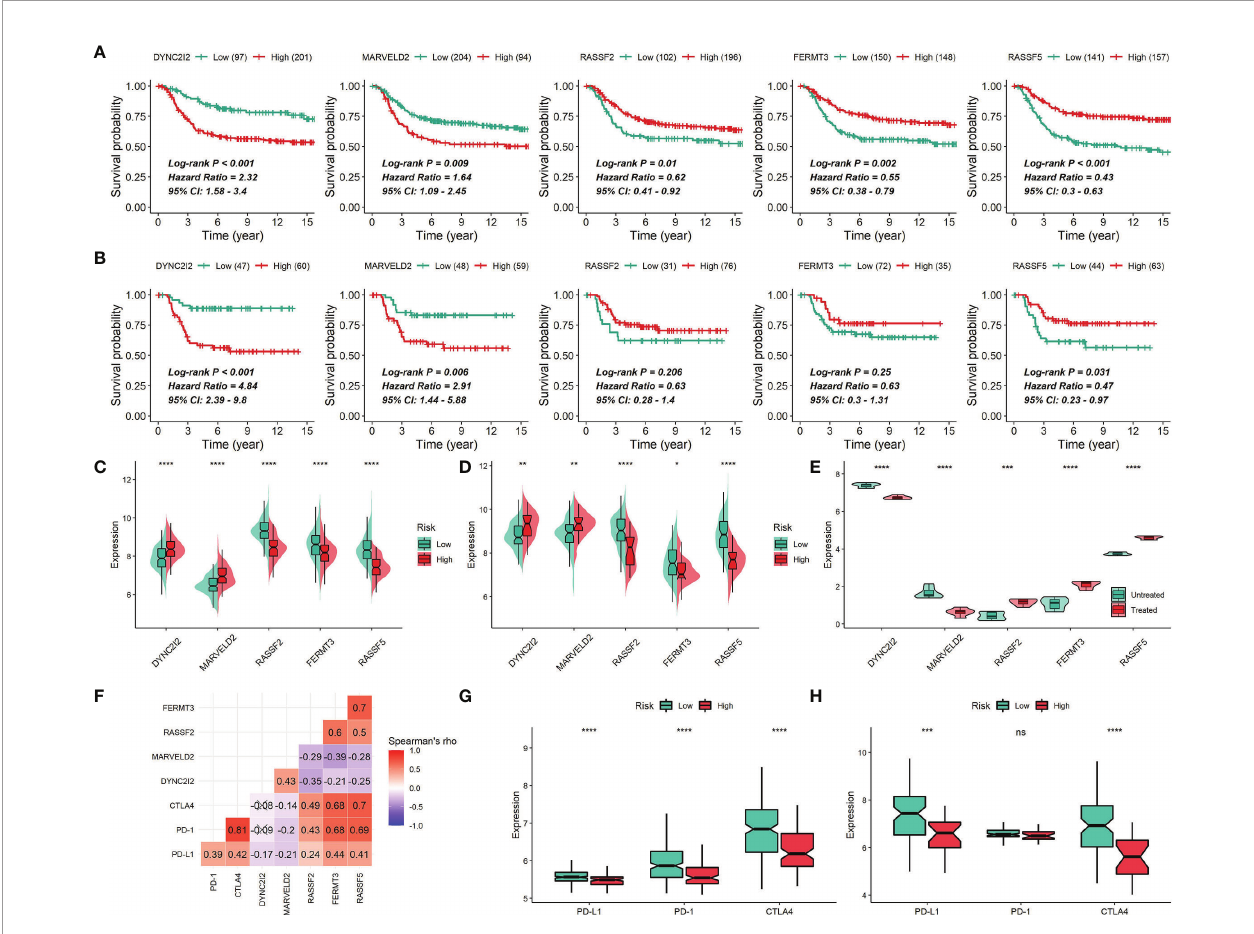
FIGURE 12 | Gene expression of DYNC2I2, MARVELD2, RASSF2, FERMT3 and RASSF5. (A, B) Correlations of DYNC2I2, MARVELD2, RASSF2, FERMT3 and RASSF5 expression with survival time in the METABRIC cohort (A) or the GSE58812 cohort (B) . (C, D) Correlations of DYNC2I2, MARVELD2, RASSF2, FERMT3 and RASSF5 expression with survival risks in the METABRIC cohort (C) or the GSE58812 cohort (D) . (E) Differential expression of DYNC2I2, MARVELD2, RASSF2, FERMT3 and RASSF5 between CKI-treated and control groups. The P values were generated by the DESeq2 method. (F) Correlations of the expression of DYNC2I2, MARVELD2, RASSF2, FERMT3 and RASSF5 using Spearman analysis based on the METABRIC cohort. PD-L1, PD-1 and CTLA4 were also plotted. Negative correlation is marked with blue and positive correlation with red. “ × ” means the corresponding correlation coef fi cient is regarded as insigni fi cant ( P > 0.05). (G and H) Difference in PD-L1, PD-1 and CTLA4 expression among risk groups in the METABRIC cohort (G) or the GSE58812 cohort (H) (*0.01 < P < 0.05; **0.001 < P < 0.01; ***0.0001 < P < 0.001; **** P < 0.0001; ns, P >